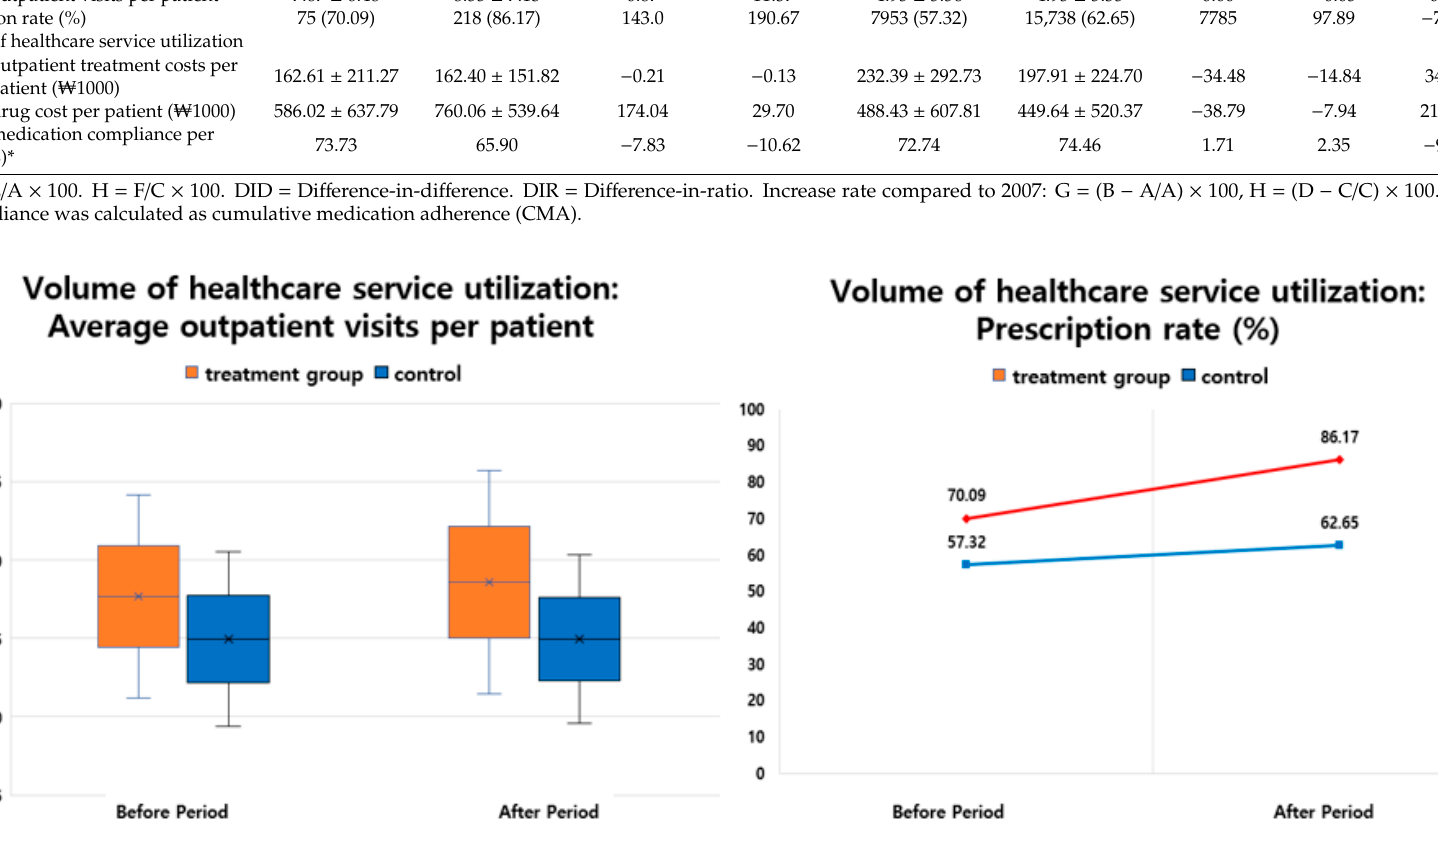
Figure 2. Outcomes of interest regarding volume of health service utilization.